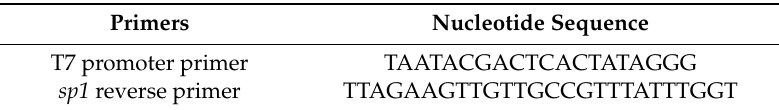
Table 7. Primers for sp1